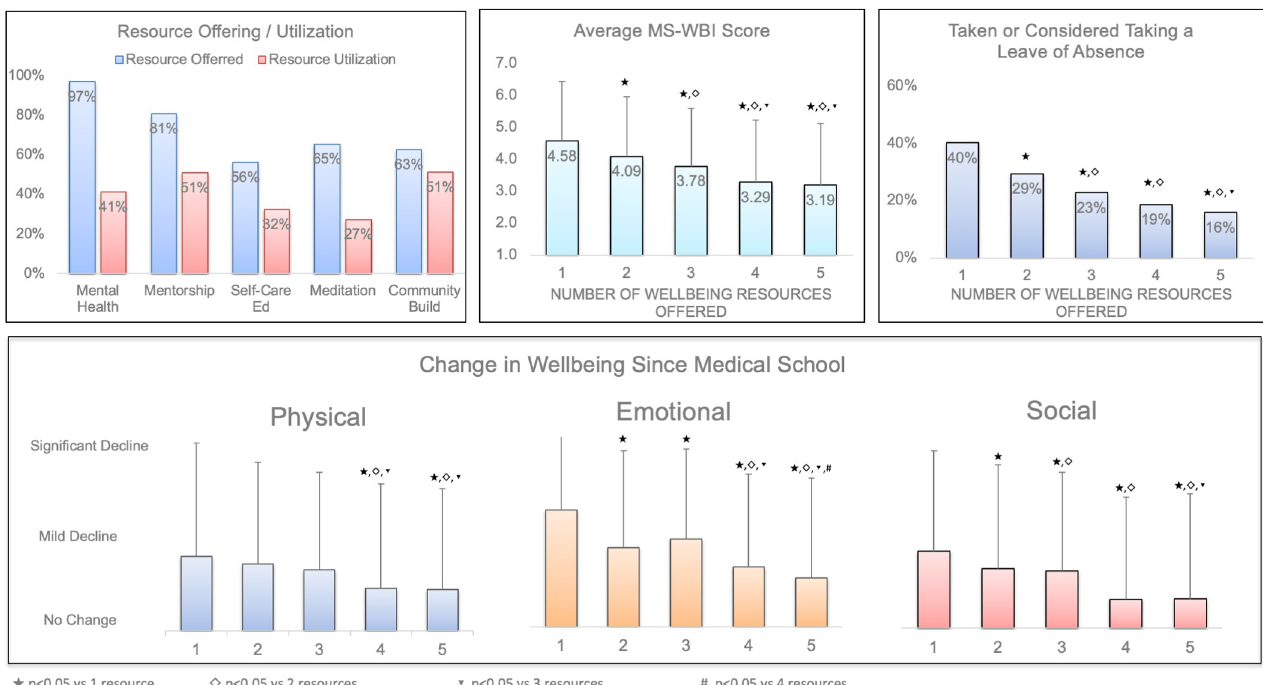
Fig 1. Impact of number of wellbeing resources offered on student distress. Availability and utilization of well-being resources (Mental Health & Counseling Services, Peer Mentorship, Self-Care Education, Mindfulness/Meditation Classes, and Community Building Events Mental Health) at US allopathic medical schools as reported by medical student survey respondents. Average MS-WBI and percentage of students who had taken or considered taking a leave of absence for personal wellbeing based on the number of reported wellbeing resources offered. Average change in students’ physical, emotional, and mental well- being based on the number of wellbeing resources offered. Error bars represent standard deviation, p-value vs. 1, 2, 3 and 4 wellbeing resources noted in key.